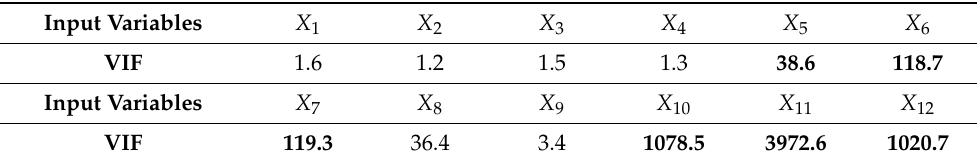
Table 3. Variance inflation factor (VIF) values of input variables.